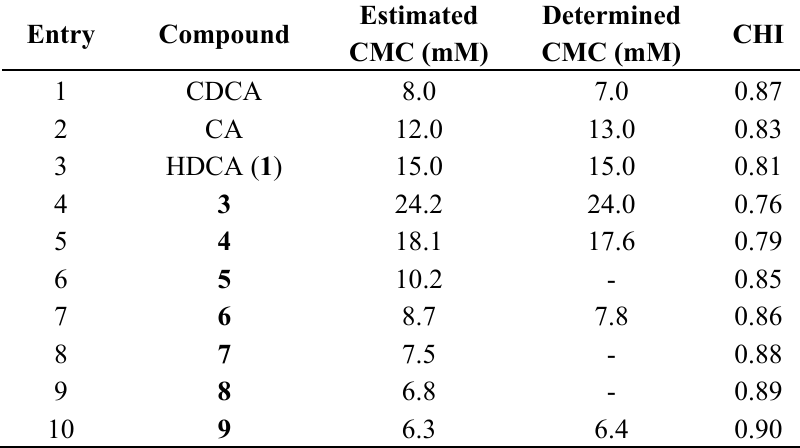
Table 1. CMC values of the investigated HDCA derivative sodium salts with respect to CDCA and